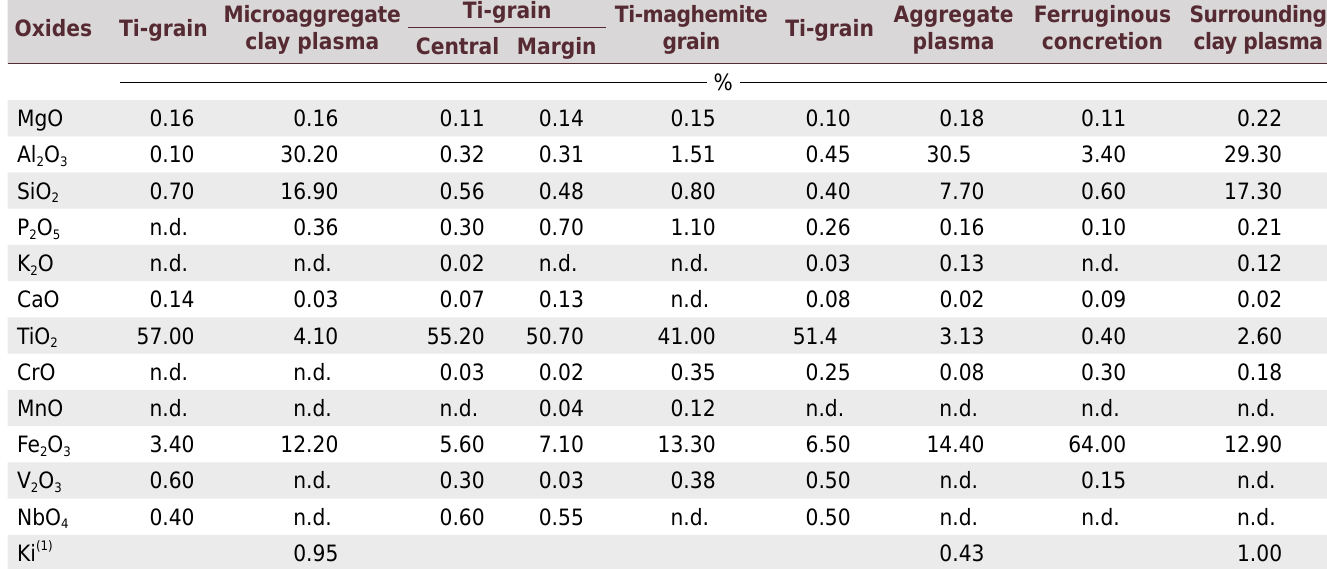
Table 4. The SEM-WDS microchemical analysis of selected pedofeatures of the Bw 2 horizon in the P 3 - Geric Acric Rhodic Ferralsol (Clayic, Dystric); Serra do Salitre topolithosequence Microaggregate Oxides Ti-grain clay plasma